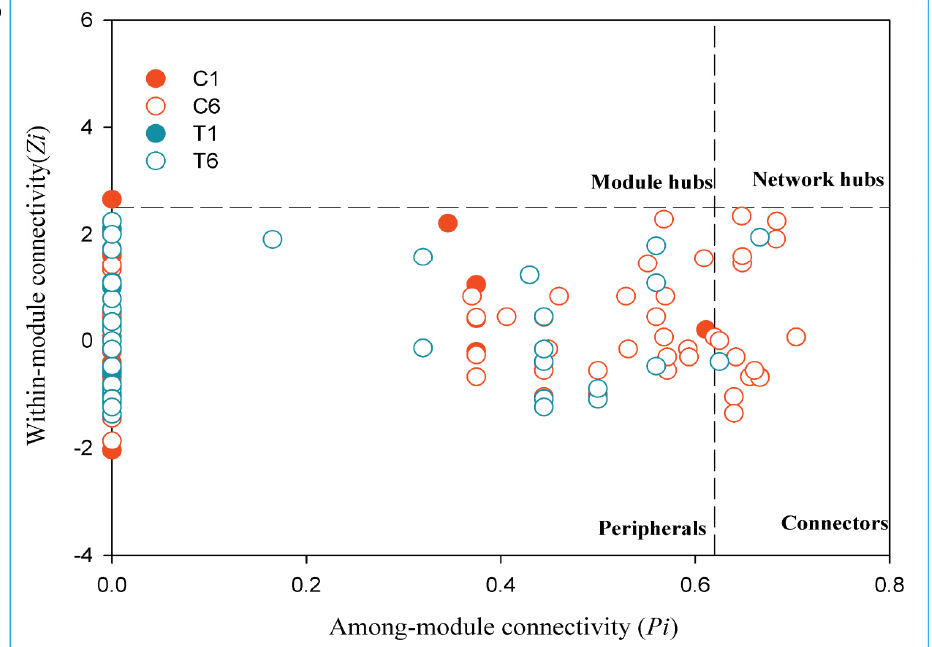
Figure 5. Dynamic changes of the phylogenetic interactional network. ( a ). Network interactions of intestinal microbiota in NS-NSCLC patients between C and T. Node colors mean different phyla; pie charts mean the module composition. The blue links indicate the negative correlations between two phyla, and the grey links indicate the positive correlations. The number means the ratio of negative links accounting for the total links. ( b ). Z – P plot showing the distribution of OTUs based on their topological